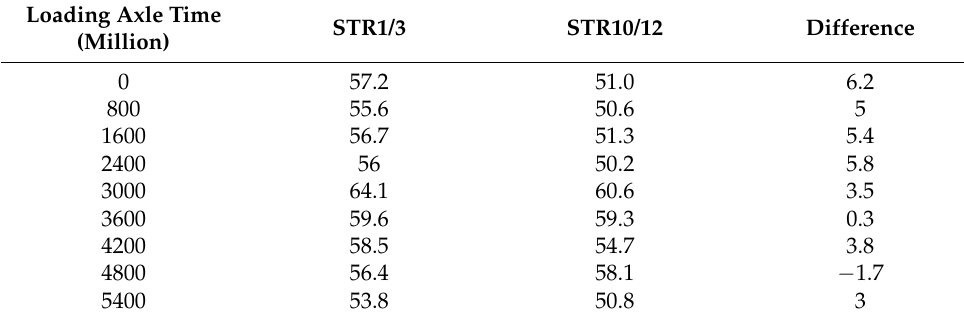
Table 6. Comparison of STR1/3 and STR10/12 characteristic temperature T 5